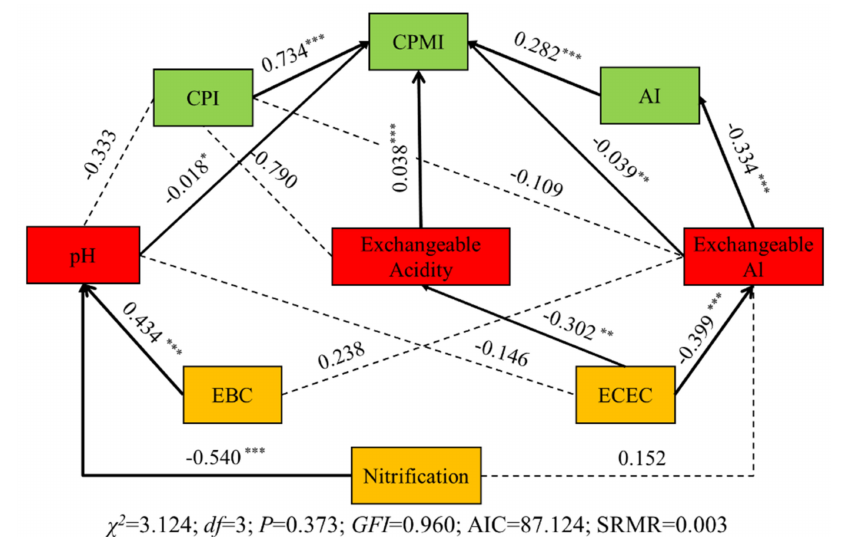
Figure 5. Structural equation modeling (SEM) of the effects of submergence on organic carbon pool as a result of submergence-induced changes in soil acidification and soil environment. Square boxes denote variables included in the models. Values associated with solid arrows represent standard-ized path coefficients (SPCs) and asterisks mark their significance: *, Pb 0.05; **, Pb 0.01; ***, Pb 0.001. Solid arrows denote the directions and effects that were significant ( p < 0.05), and the thickness represents the magnitude of the path coefficients. Dashed arrows represent the directions and ef-fects that were non-significant ( p < 0.05). EBC, total exchangeable base content; ECEC, effective cat-on exchange capacity; CPI, carbon pool index; AI, activity index of the carbon pool; CPMI, carbon pool management